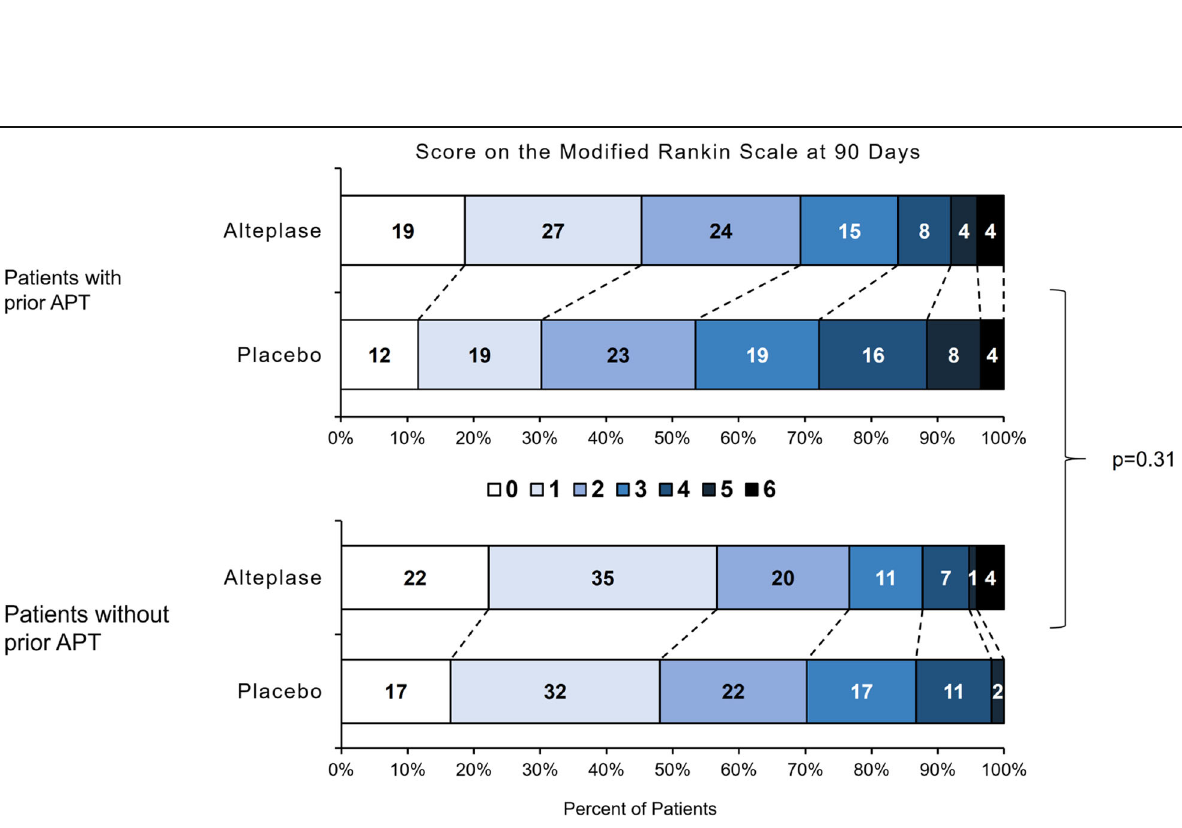
Fig. 3 Distribution of modified Rankin scale scores at 90 days after stroke. Distributions of scores on the modified Rankin scale show a favoring of the alteplase group over the placebo group. Modified Rankin scale scores range from 0 to 6 (0, no symptoms; 1, no clinically significant disability; 2, slight disability; 3, moderate disability; 4, moderately severe disability; 5, severe disability; 6, death). Numbers indicate rounded proportions. There was no significant interaction in the corresponding unconditional logistic regression